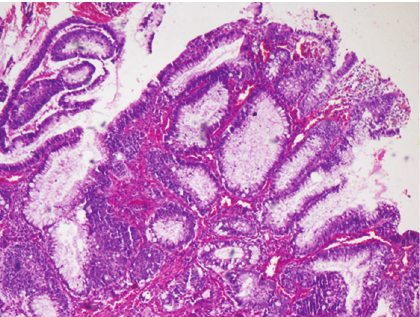
Figure 1: Ulcerated polypoidal epithelium showing extensive intes- tinal metaplasia and dysplasia (H&E, 10x).